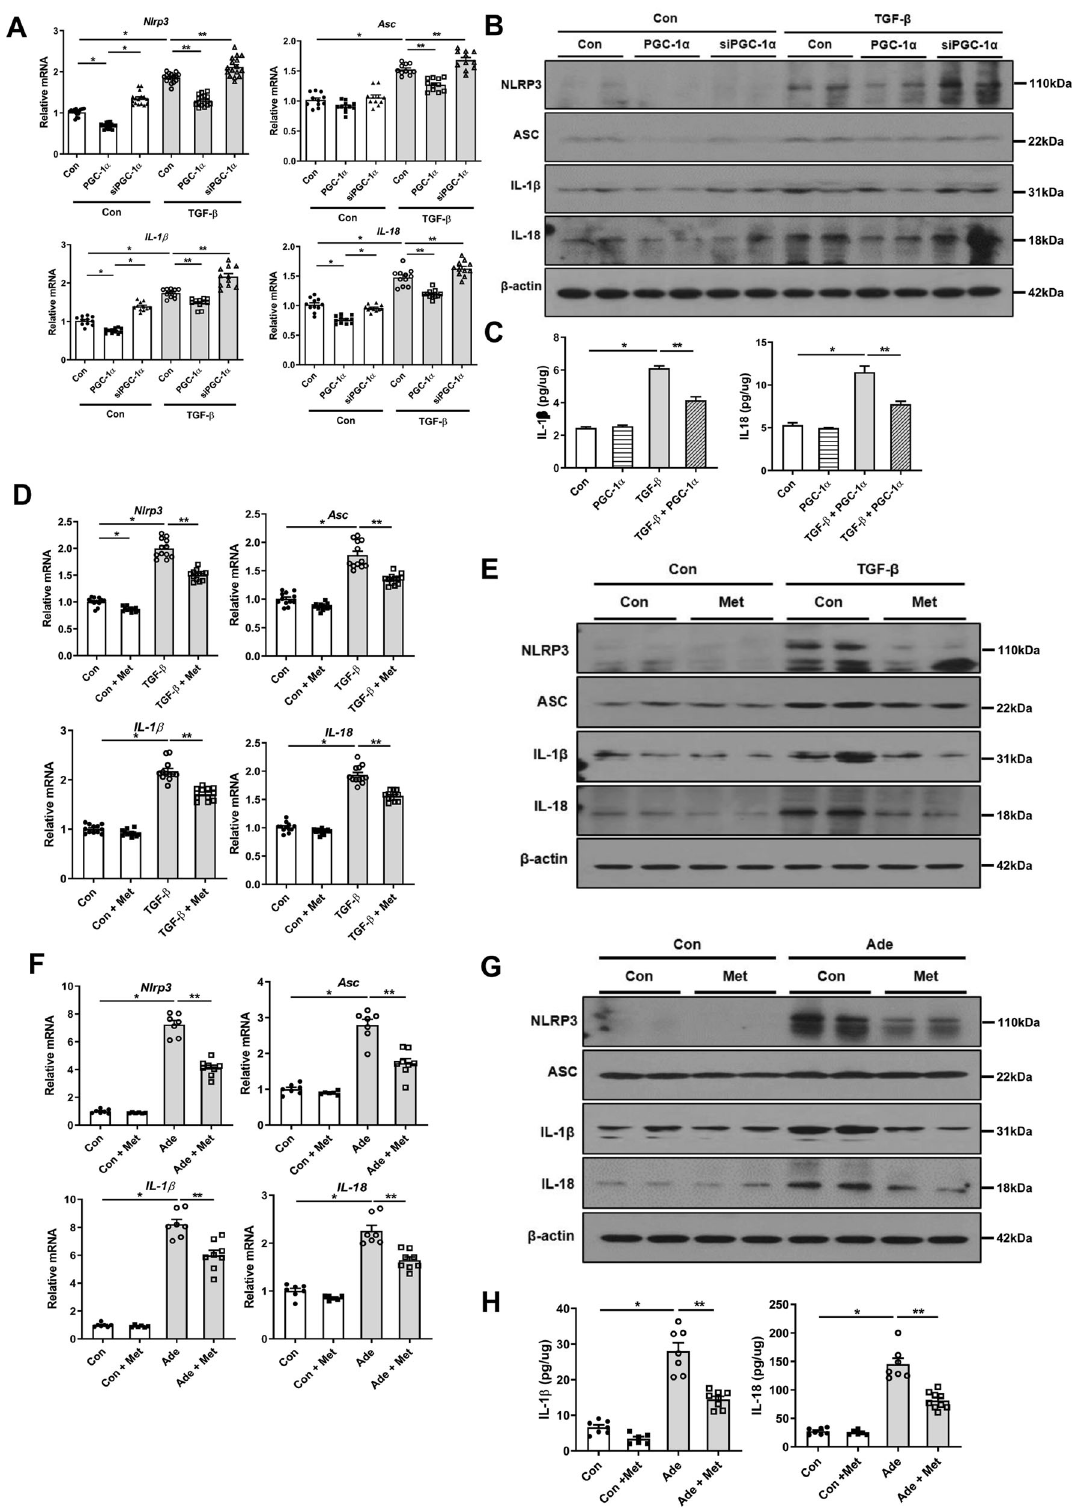
Fig. 5 PGC-1 α modulates the NLRP3 in fl ammasome signaling pathway. A mRNA and B protein expression levels of NLRP3 in fl ammasome pathway were reduced in TGF- β 1-treated RTECs with transfection of Ppargc1a plasmid, whereas increased by siPGC-1 α . C Concentrations of IL- 1 β and IL-18 assessed by ELISA were reduced in TGF- β 1-treated RTECs with overexpression of Ppargc1a . D mRNA and E protein expression levels of the NLRP3 in fl ammasome pathway were attenuated in TGF- β 1-treated RTECs with metformin. F mRNA and G protein expression levels of the NLRP3 in fl ammasome pathway and H concentrations of IL-1 β and IL-18 assessed by ELISA were attenuated in adenine-fed mice with metformin. Note: * P < 0.05 vs. control; ** P < 0.05 vs. TGF- β 1-treated RTECs or adenine-fed mice. PGC-1 α peroxisomal proliferator- γ coactivator-1 α ; NLRP3 NOD-like receptor family, pyrin domain-containing 3; ASC apoptosis-associated speck-like protein containing a caspase recruitment domain; RTEC renal tubular epithelial cell; ELISA enzyme-linked immunosorbent assay; Ade adenine; Met metformin. Cell Death and Disease (2022)